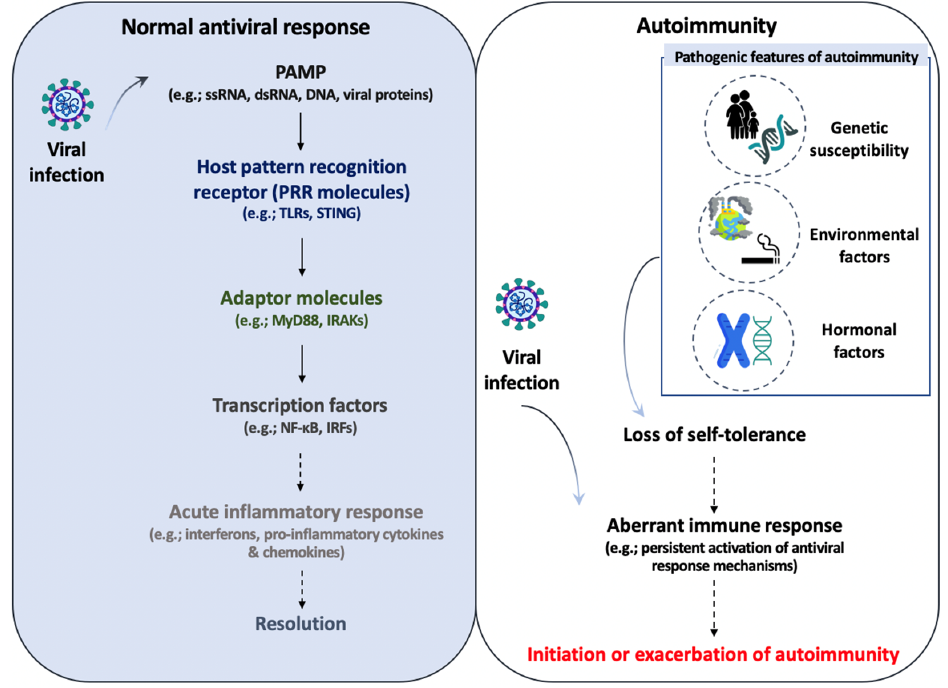
Figure 2. PRR signaling upon viral infection may either lead to acute inflammatory response and resolution or trigger autoimmune responses. Innate immunity is activated upon viral exposure, and the response is mediated through pattern recognition receptor (PRR) molecules that recognize the viral nucleic acids, the adaptor molecules that mediate the signal to downstream components, and the transcription factors that are responsible for the outcome. An acute inflammatory response is orchestrated by the release of antiviral molecules, such as interferons, proinflammatory cytokines, and chemokines at sites of infection. In autoimmune diseases, a combination of genetic susceptibility, such as gene copy variations and single-nucleotide polymorphisms (SNPs) and environmental as well as hormonal factors including UV light, toxic chemicals, and genes defined by the X chromosome, leads to loss of self-tolerance and chronic inflammation. In this environment, when a viral infection occurs, the host defense mechanisms are exposed and may promote an exaggerated immune response, which can lead to initiation or exacerbation of autoimmunity.